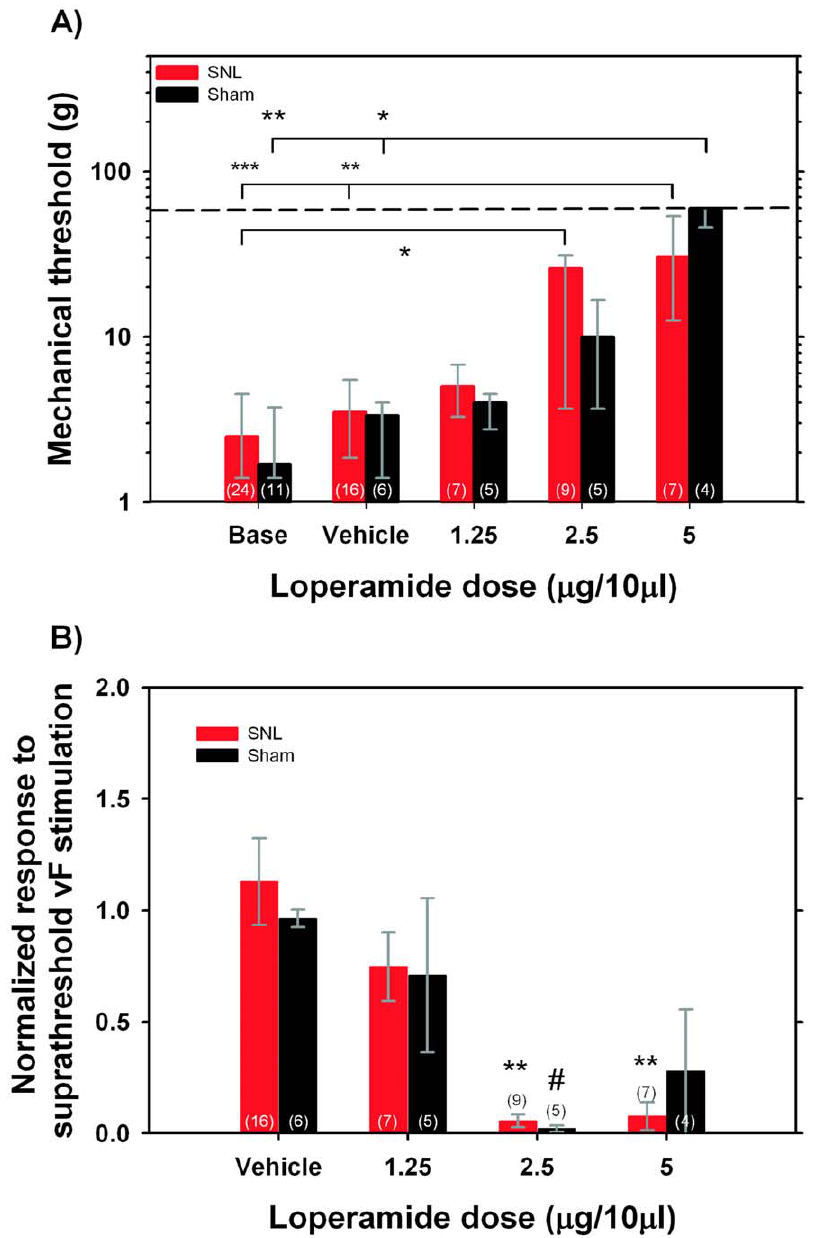
Figure 2. Loperamide decreases mechanical responsiveness of unmyelinated, nociceptive C-fibers. A) Loperamide dose-dependently increases mechanical thresholds in both sham operated and spinal nerve lesioned (SNL) animals. Kruskal Wallis ANOVA (p , 0.01 in both groups) was followed in each group by multiple post-hoc comparisons between mean ranks. Significant differences are indicated as *p , 0.05, **p , 0.01, ***p , 0.001. At no given dose was there a significant difference between SNL and sham group (Mann Whitney U test, n.s.). Medians, 75th and 25th percentile are plotted. Numbers of fibers studied in each group and dose are given in parentheses. Dashed line indicates threshold assigned to afferents unresponsive to 25 g vF hair. B) Loperamide dose-dependently decreases the responsiveness to suprathreshold mechanical stimuli in both animal groups (ANOVA lesion: F (3,35) =10.3, p , 0.001; ANOVA sham: F (3,16) =4.5, p , 0.05). Post hoc comparisons revealed significant differences between vehicle and different loperamide doses where indicated (Scheffe test; **p , 0.01, * # p , 0.05). Numbers in parentheses state the total number of fibers studied in each group and dose.